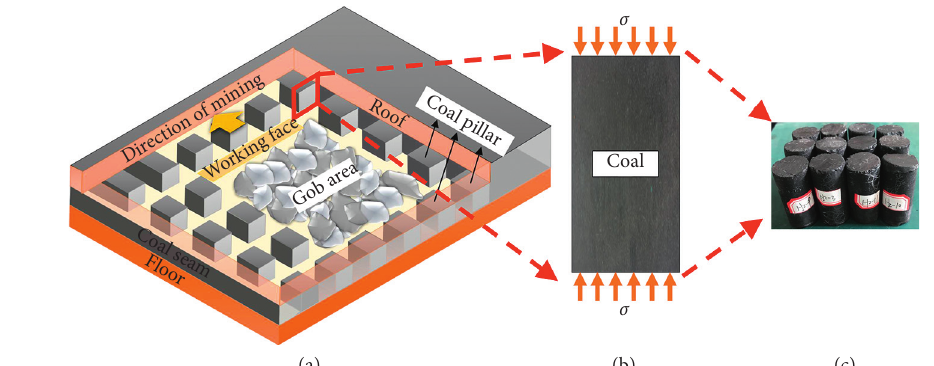
Figure 2: A schematic of room and pillar recovery in residual coal seam: (a) plane view of room and pillar recovery in residual coal seam; (b) the simplified model of coal pillar stress condition; (c) coal samples. Table 1: Loading conditions of samples. Coal samples Loading rates (m/s)